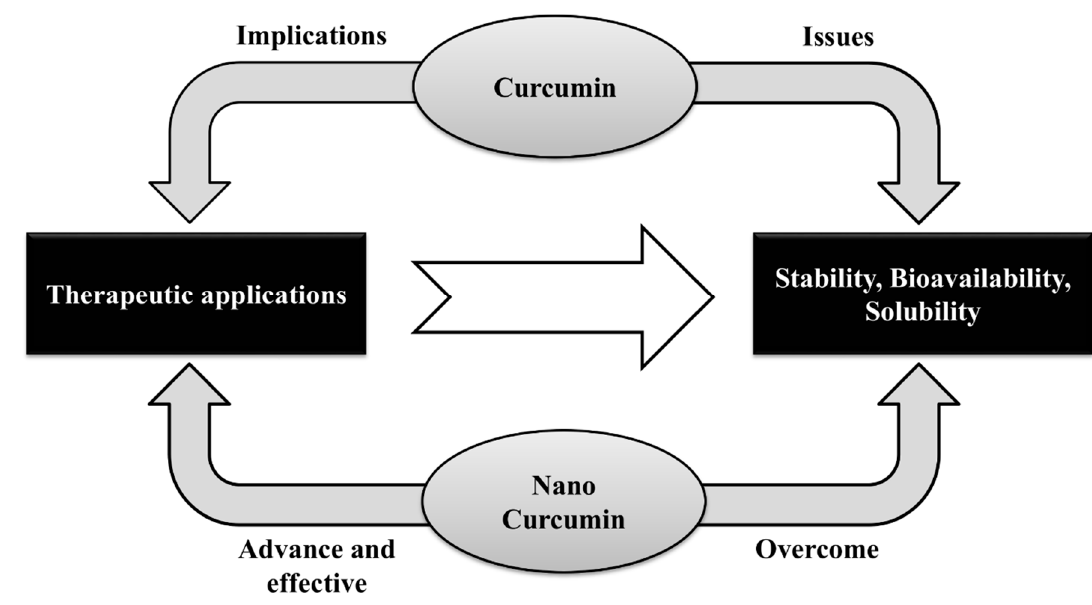
Figure 3. Curcumin and nanocurcumin.